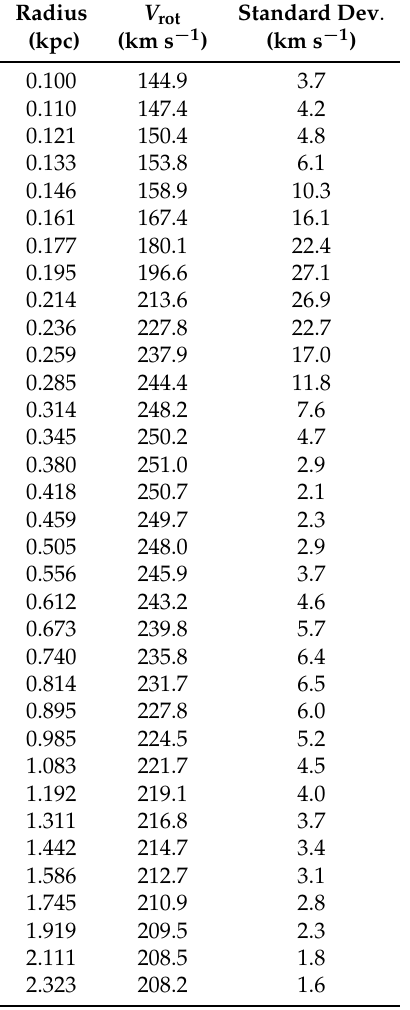
Table A1. Rotation curve of the Milky Way used in Figure